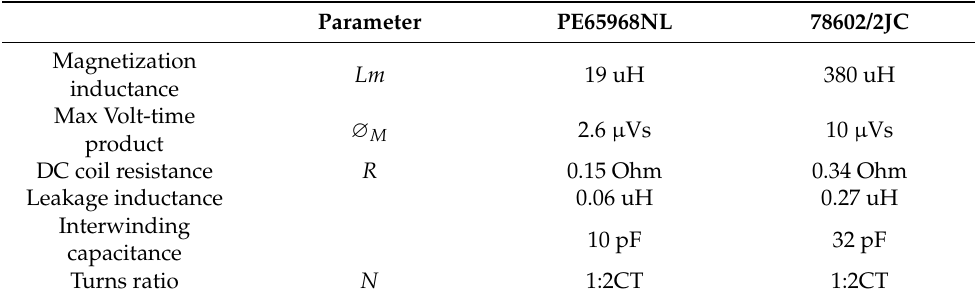
Table 2. Transformers’ features.